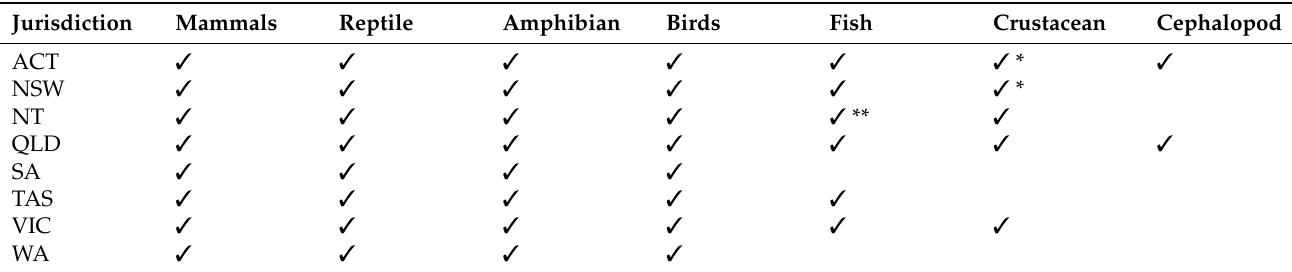
Table 3. Statutory definition of ‘animal’ in each state and territories’ animal welfare act. References as follows: ACT [28], NSW [29], NT [30], QLD [27], SA [31], TAS [32], VIC [26], and WA [33].